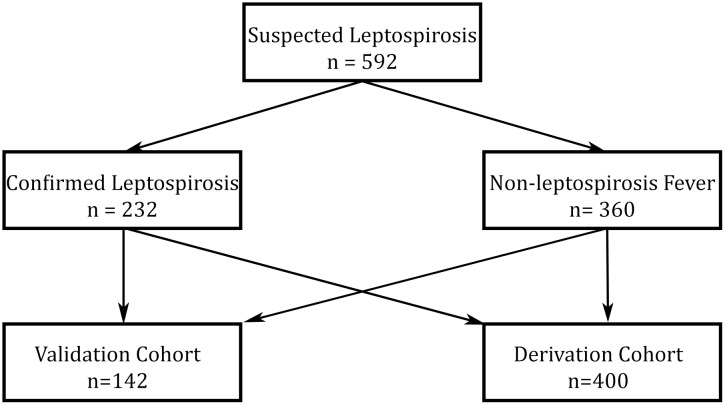
Schematic flow diagram of study subject categorization.